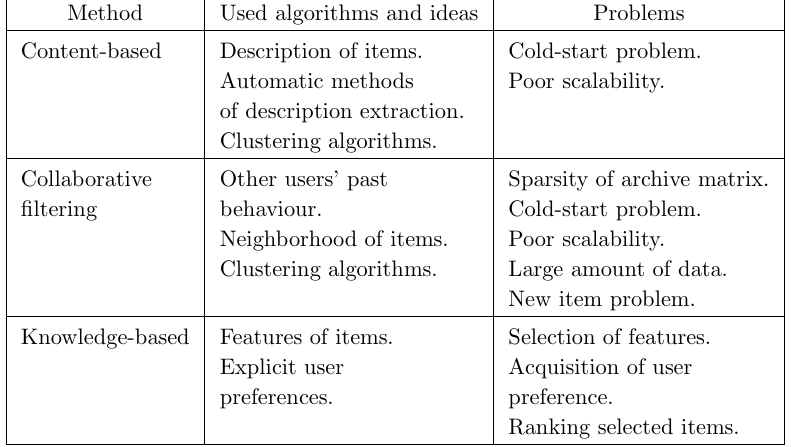
Division, methods and problems in recommender systems